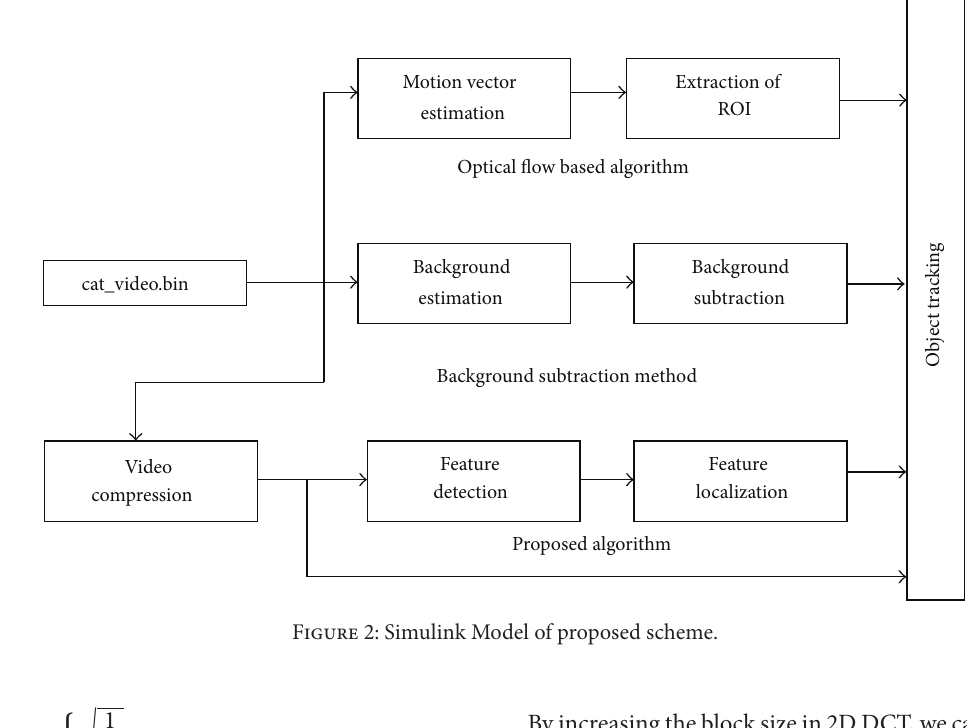
Figure 2: Simulink Model of proposed